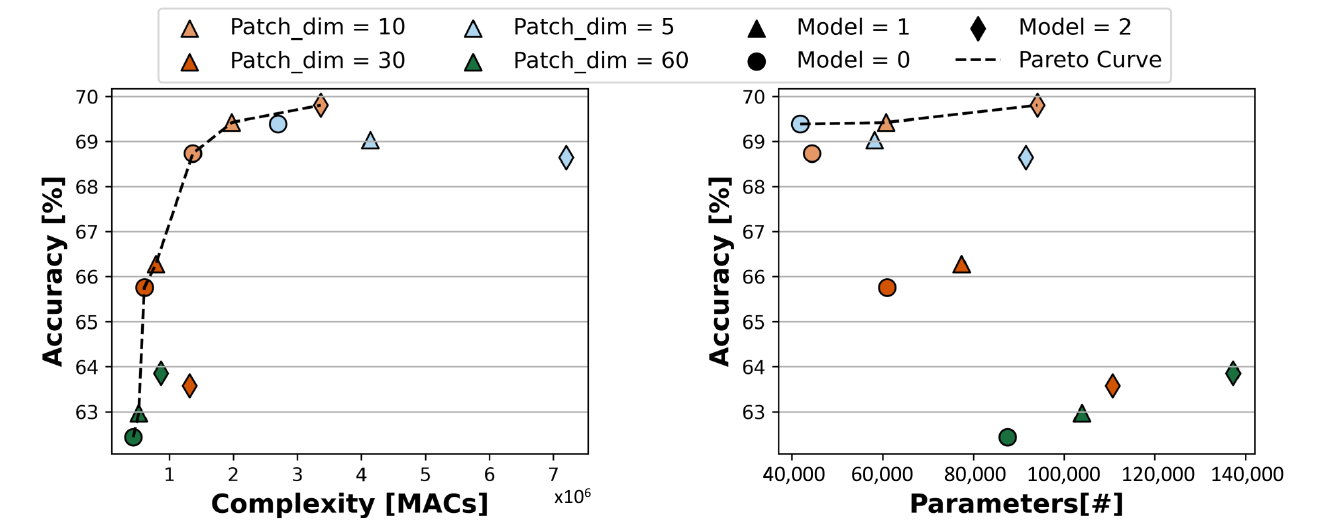
Figure 6. Patch size exploration